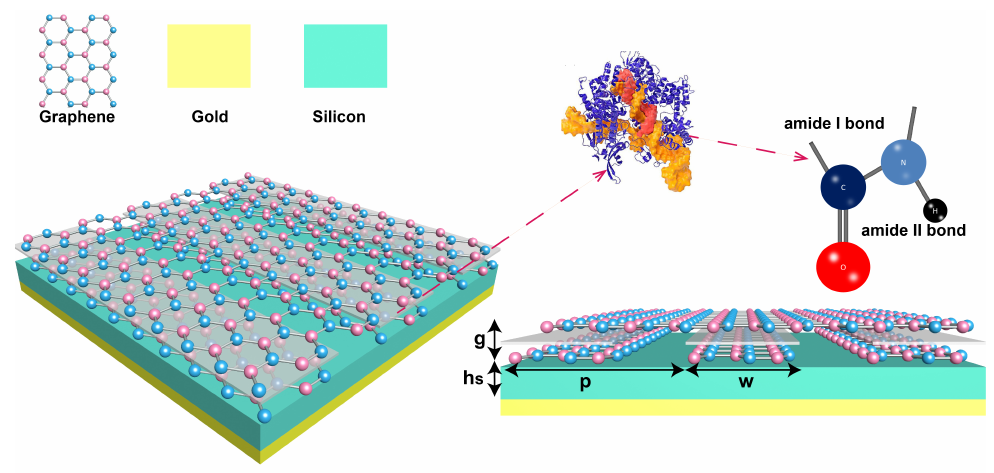
Figure 1. Schematic of the graphene plasmonic system including from top to bottom: continuous graphene, nano-gap and graphene ribbons, dielectric spacer layer, and metal mirror substrate. The protein sensing analytes are placed inside the nano-gap. THe peptide bond, a basic chemical bond of the polypeptide chain, includes the C=O bond (amide I) and C–N bond (amide